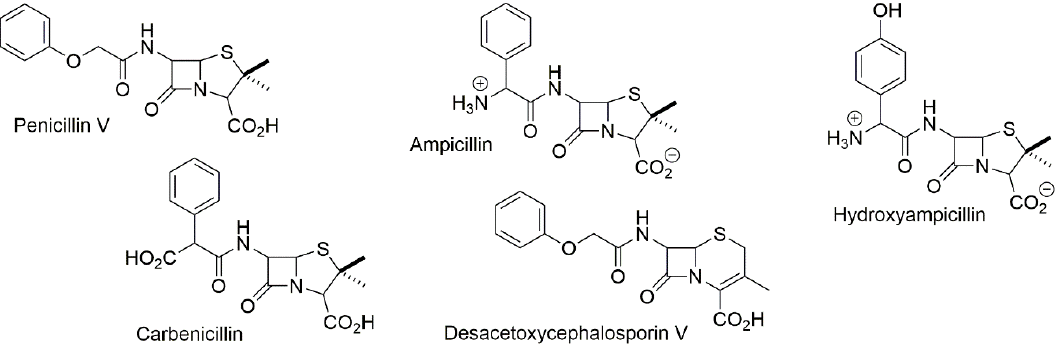
Figure 3. Unstable β -lactam antibiotics synthesized using protective group technique of Scheme 1 .